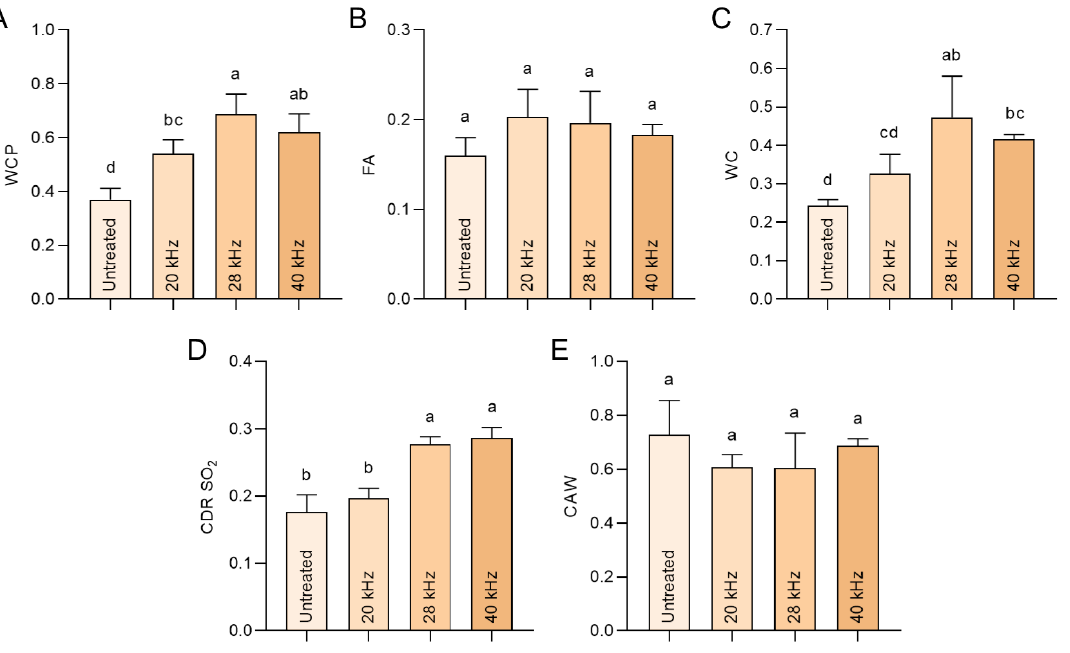
Figure 2. Anthocyanin color values of wine. The color values originating from anthocyanins were determined in the wine after three months of aging. ( A ) Wine color due to pigments (WCP). ( B ) Free anthocyanins (FA). ( C ) Wine color (WC). ( D ) Color due to pigment derivatives resistant to SO 2 (CDR SO 2 ). ( E ) Chemical age of wine (CAW). Different letters indicate a significant difference between the groups.